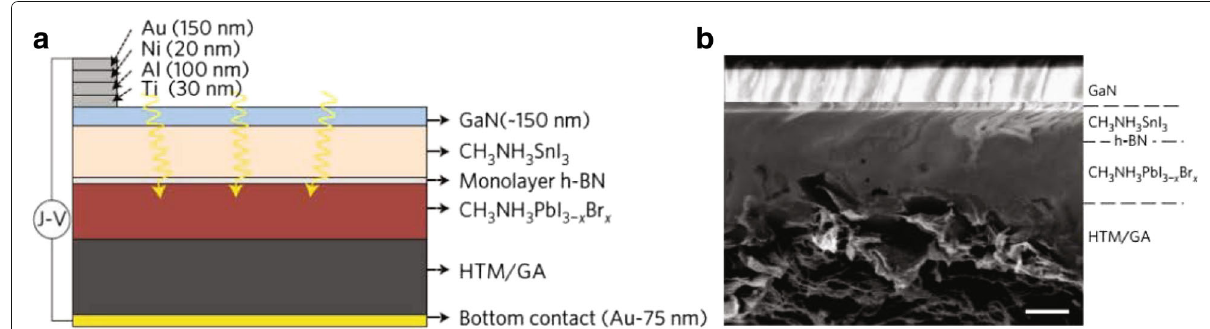
Fig. 5 Cross-sectional schematic and SEM images of perovskite cell with integral monolayer h-BN and graphene aerogel. a Schematic of a graded bandgap perovskite solar cell. Gallium nitride (GaN), monolayer hexagonal boron nitride (h-BN), and graphene aerogel (GA) are key components of the high-efficiency cell architecture. b Cross-sectional SEM image of a representative perovskite device. The division between perovskite layers and the monolayer h-BN is not visible in this SEM image. The dashedlines indicate the approximate location of the perovskite layers and the monolayer h-BN as a guide to the eye. The location of perovskite layers and monolayer h-BN is extracted from the related EDAX analysis. Thickness of the